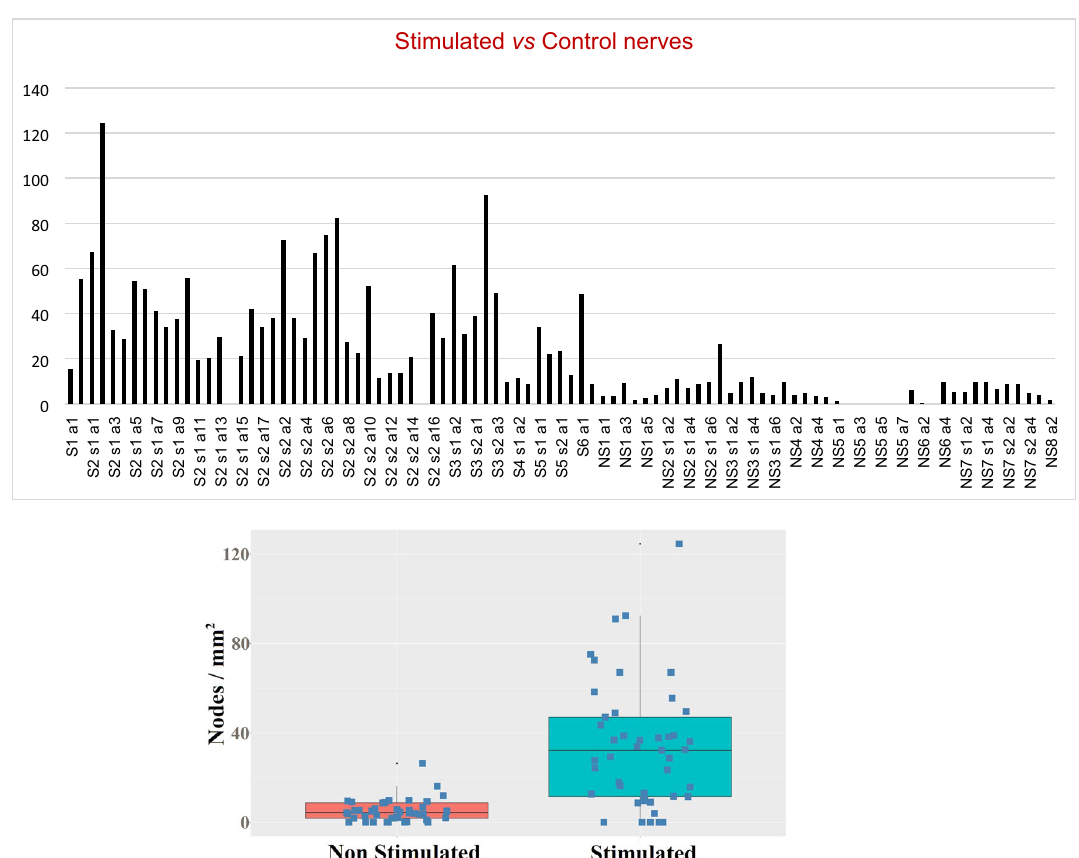
Figure 3. Up: Nodes’ density in sample areas in control nerves and nodes’ density in sample areas in stimulated nerves. NS non-stimulated (control nerve), S stimulated nerve, s section, a sample area (n integer, number of nerve, section and sample respectively); Down: Node density of “non stimulated” and “stimulated” sample groups represented as a boxplot including average values and standard